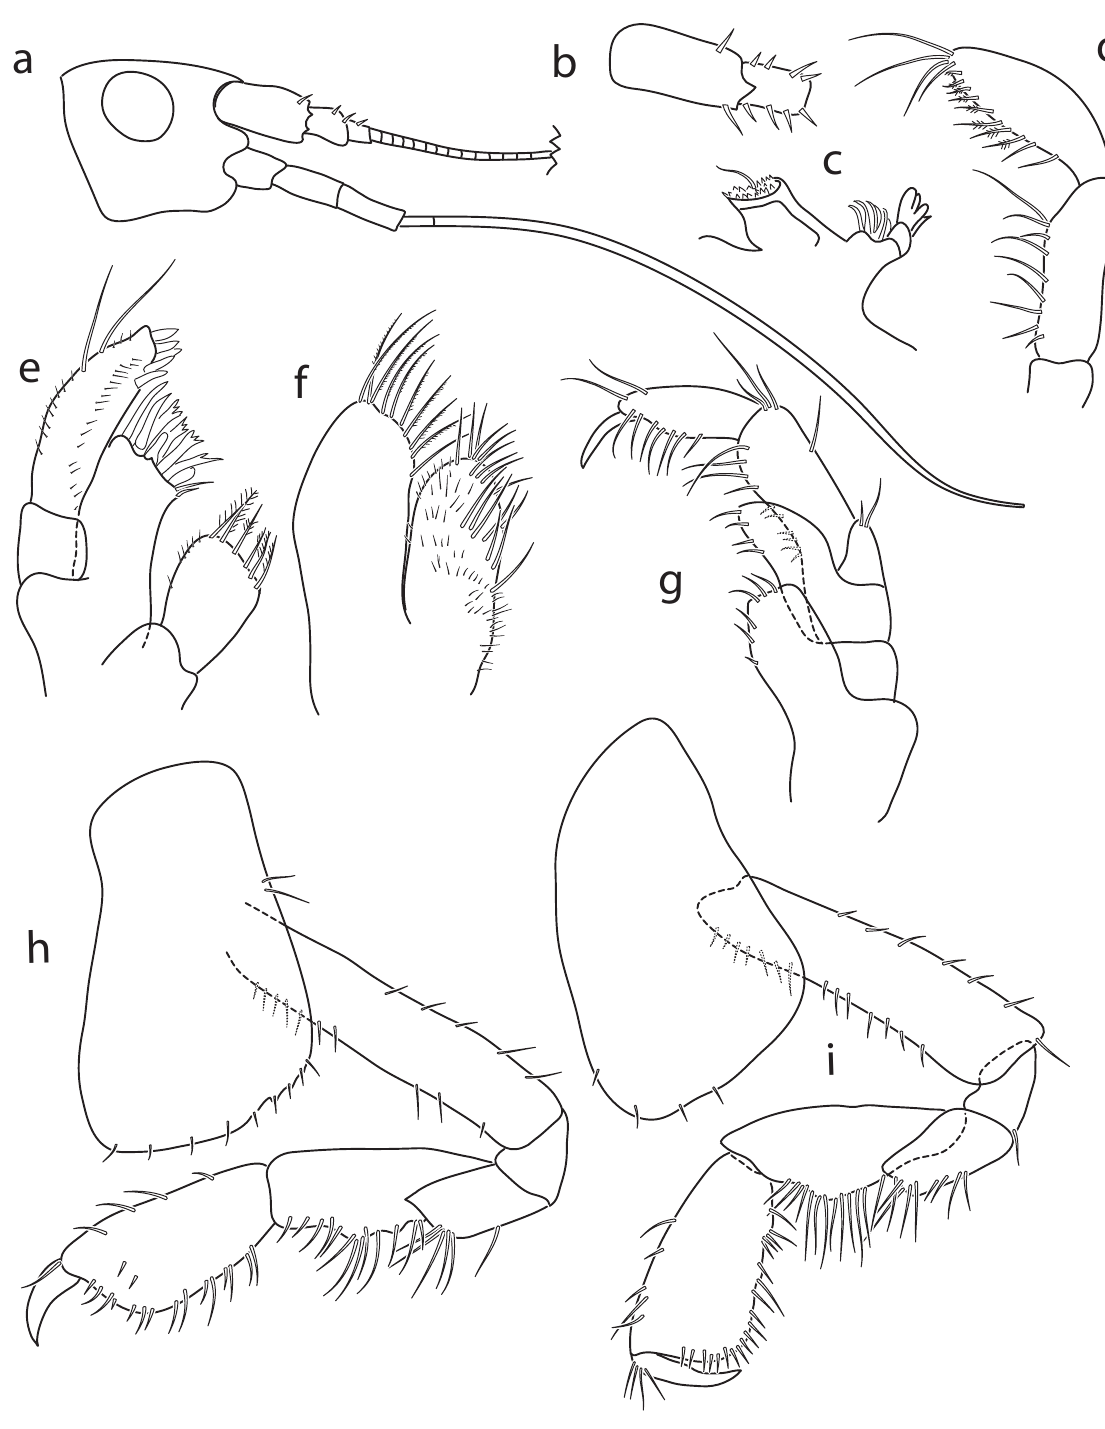
Fig. 24. Liouvillea rocagloria sp. nov., holotype, ♀, 8 mm (MVRCr 7734). a . Right side of head with antenna 1 and 2. b . Articles 1–2 of antenna 1. c . Mandible. d . Mandible palp. e . Maxilla 1. f . Maxilla 2. g . Maxilliped. h . Gnathopod 1. i . Gnathopd 2. Figure not